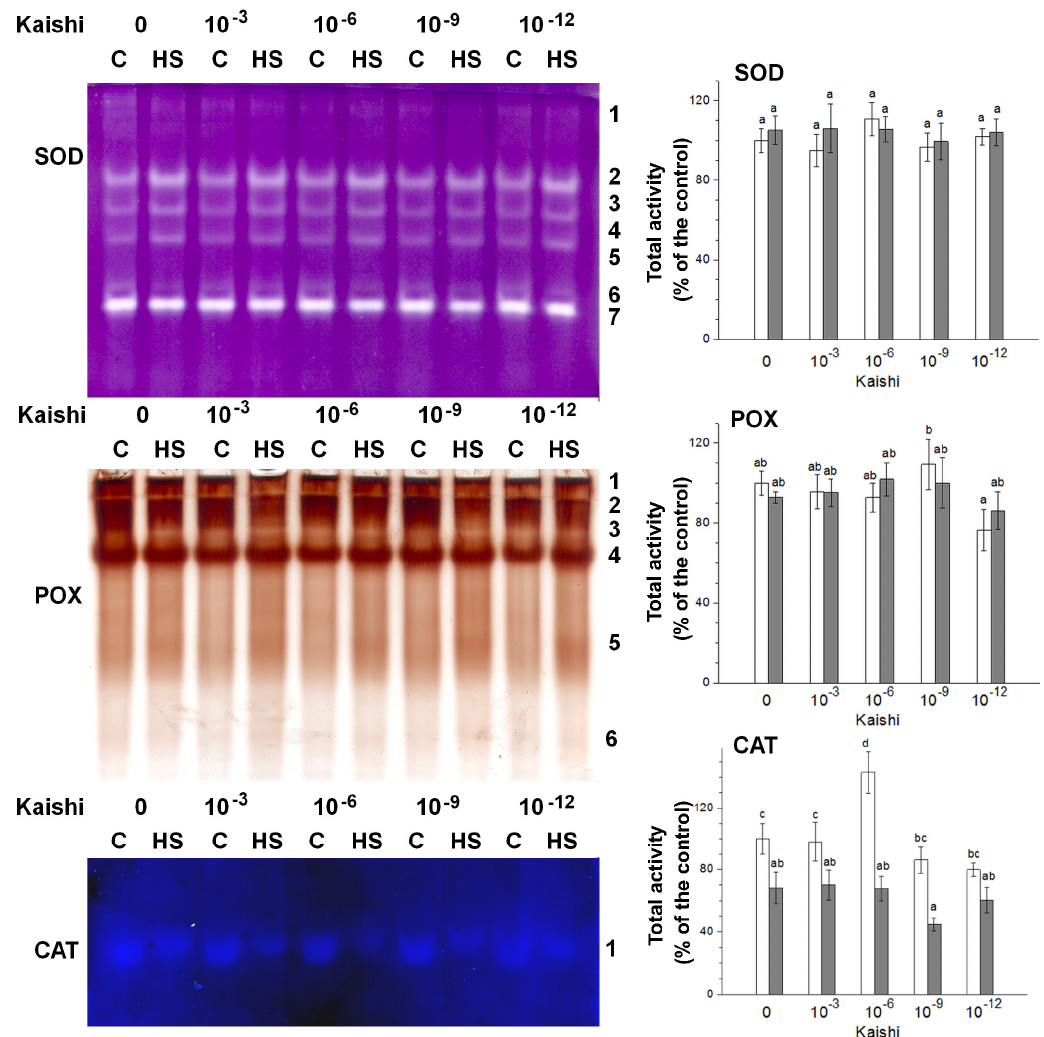
Figure 3. In-gel activity staining of SOD (40 µ g of protein loaded per each lane), POX (20 µ g of protein loaded per each lane), and CAT (60 µ g of protein loaded per each lane) antioxidant enzymes visualized by representative gel images. The numbers along the right side of the gels indicate the positions of the distinct isoforms. The graphs represent mean values of three separate measurements of the staining intensity performed with ImageJ ( n = 3 ± SE). The results are expressed as % of the control. White columns indicate the measured total enzyme activity in the non-stressed variants, and the grey columns depict the activity in the heat-stressed individuals from the same treatment group. Different letters above the columns indicate significant differences at p < 0.05 (multifactor ANOVA).